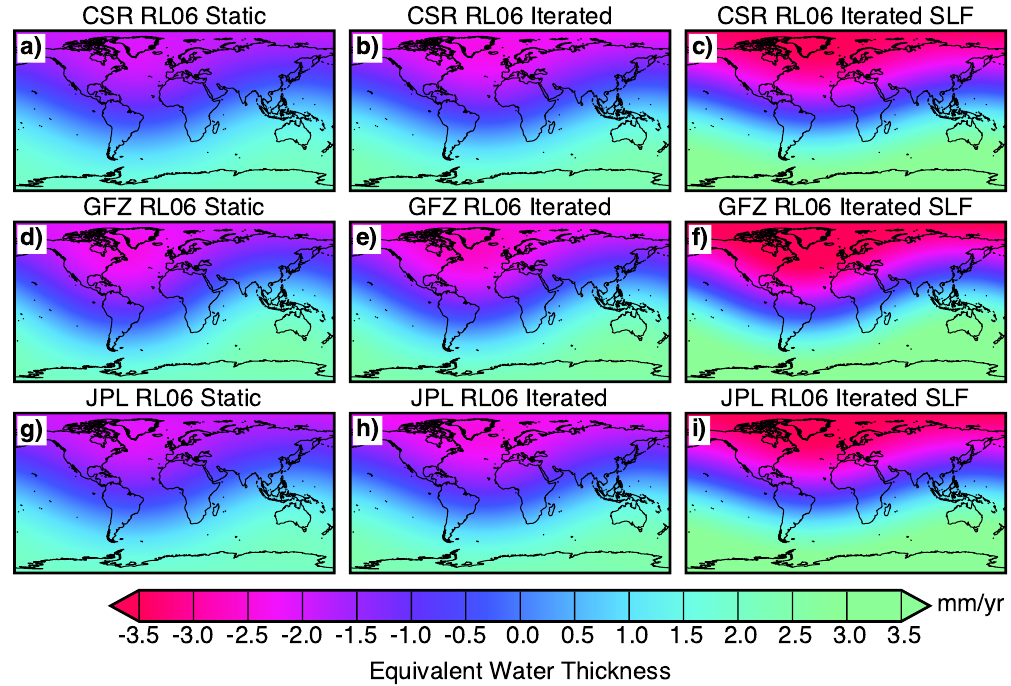
Figure 6. Trends in recovered degree one surface mass variations in mm water equivalent calculated from time-variable gravity fields provided by the Center for Space Research ( a – c ), the German Research Centre for Geosciences ( d – f ) and the Jet Propulsion Laboratory ( g – i ). The land-sea exchange is calculated in the first column ( a , d , g ) with a static seasonal geocenter from Chen et al. [7], in the second column ( b , e , h ) with an iterated self-consistent geocenter, and in the third column ( c , f , i ) with an iterated self-consistent geocenter taking into account the effects of self-attraction and